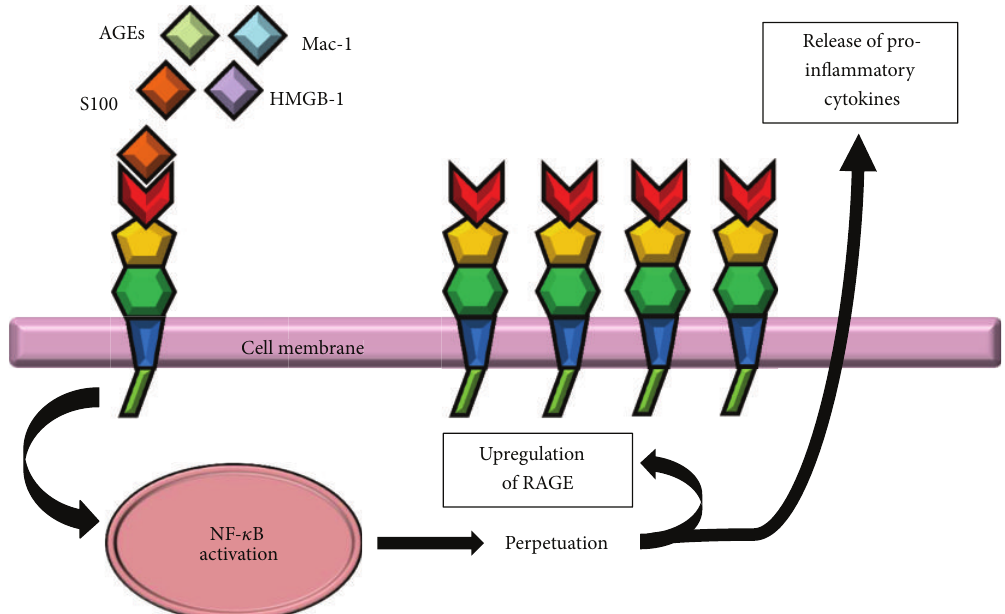
Figure 2: RAGE signalling resulting in sustained inflammation. Engagement of RAGE with various ligands including AGEs, HMGB1, S100 proteins, and 𝛽 2-integrin Mac-1 leads to an intracellular signalling cascade ultimately resulting in perpetual activation of the transcription factor NF- 𝜅 B. Since the promoter region of RAGE contains two NF- 𝜅 B response elements, RAGE is upregulated where its ligands are present, associated with an increased secretion of proinflammatory cytokines, thereby promoting inflammatory cell